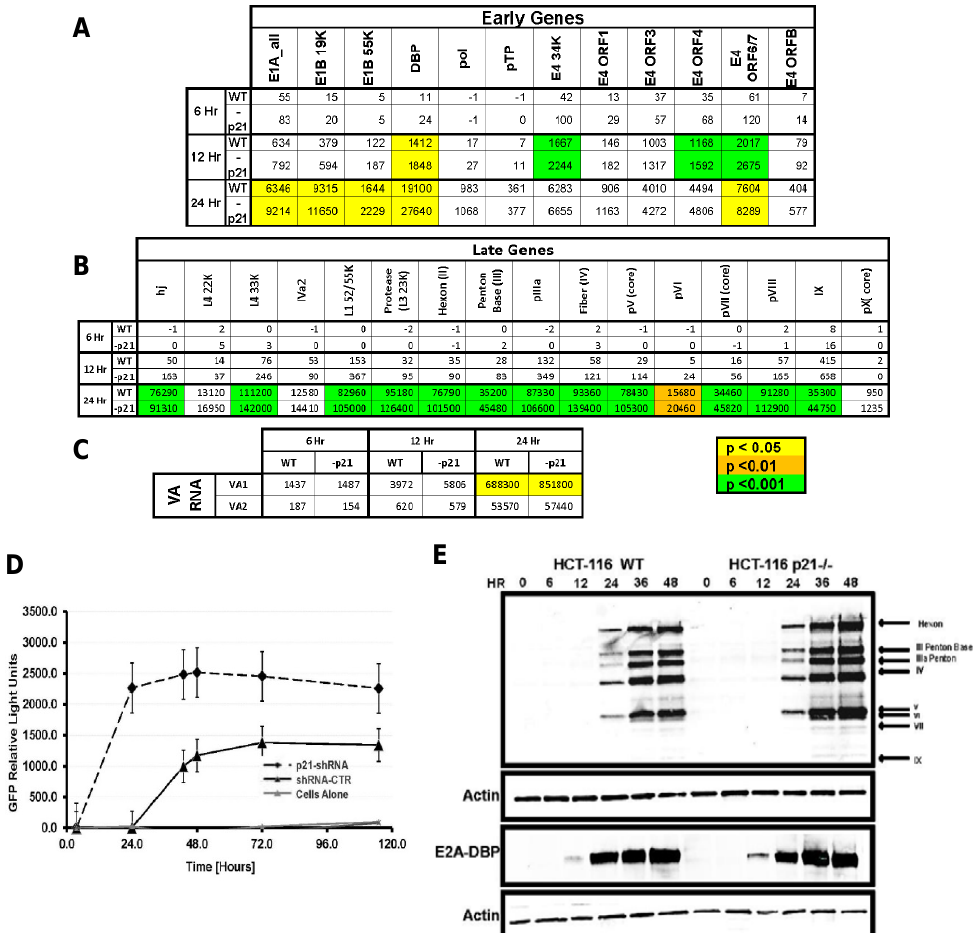
Figure 3. HCT-116 WT and p21 −/− cells were infected with 1 MOI of CN702. At indicated time points, infected cells were harvested for total RNA. 100 ng of RNA was used to run Nanostring nCounter Assay using custom Ad5 code set. Ad5 mRNA counts were normalized to internal controls and panel of housekeeping genes and quantitation of Adeno Early ( A ), Late ( B ), and VA RNA mRNA expression. The yellow, orange, and green colors indicated statistical significance with different p